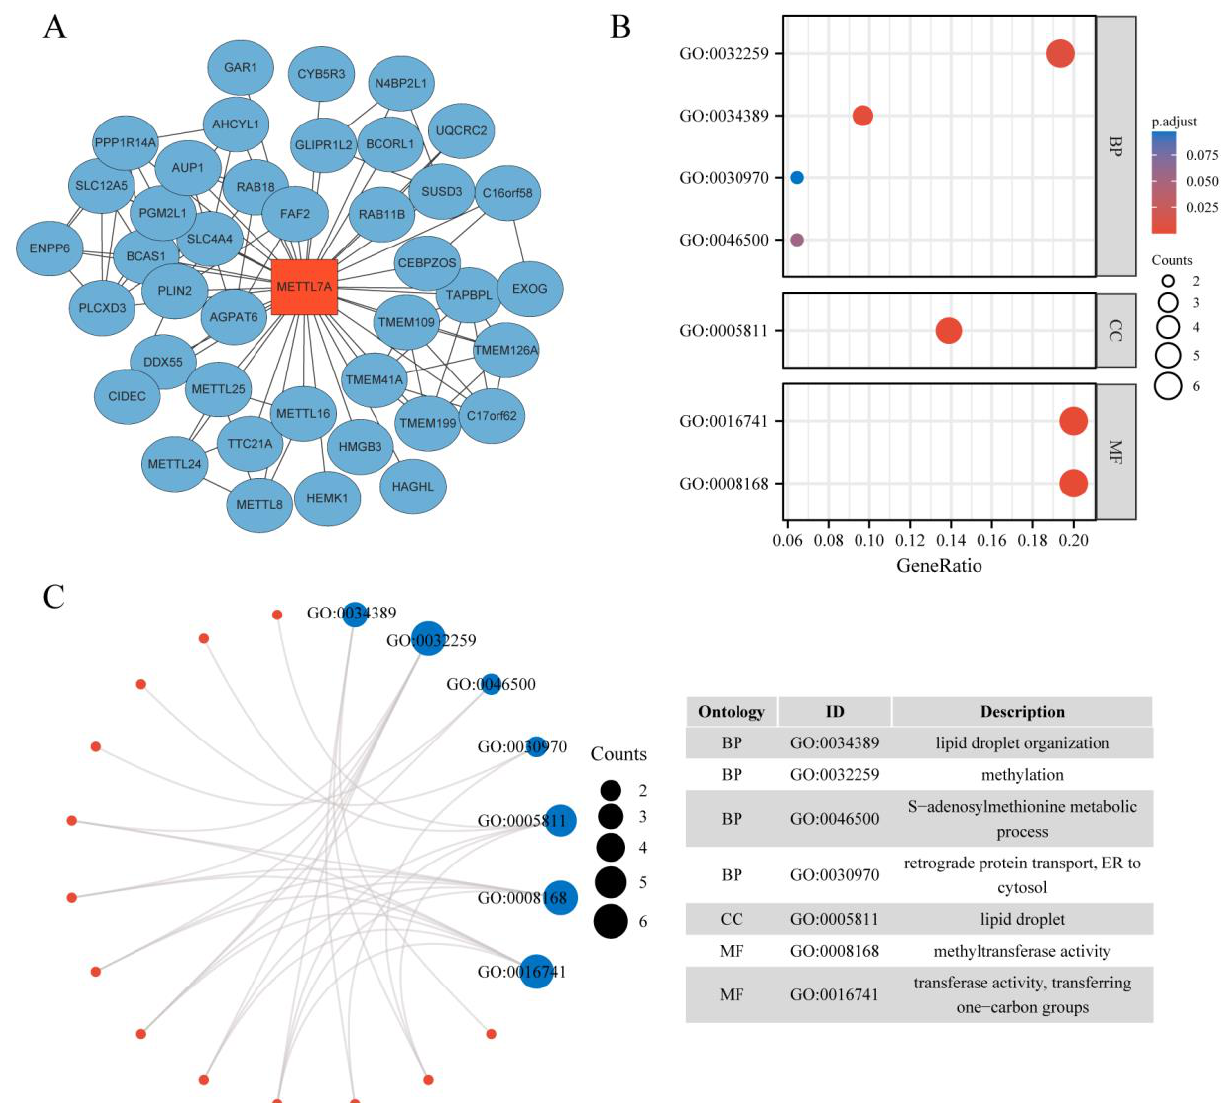
Figure 1. Protein–protein interaction (PPI) network and GO analysis of 40 targeted binding proteins of METTL7A. ( A ) PPI network; ( B ) GO analysis; ( C ) visual network of GO analysis (red: molecular; blue: enrichment